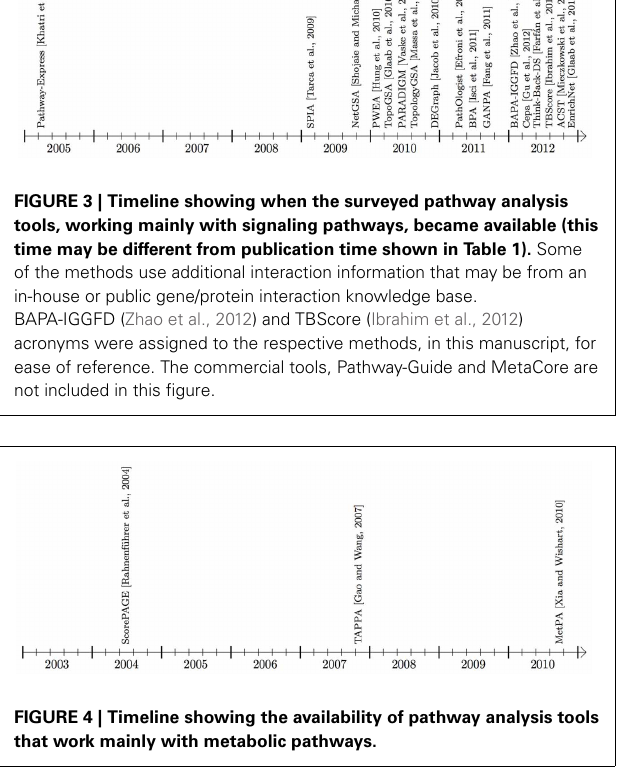
our review is the only comprehensive survey of